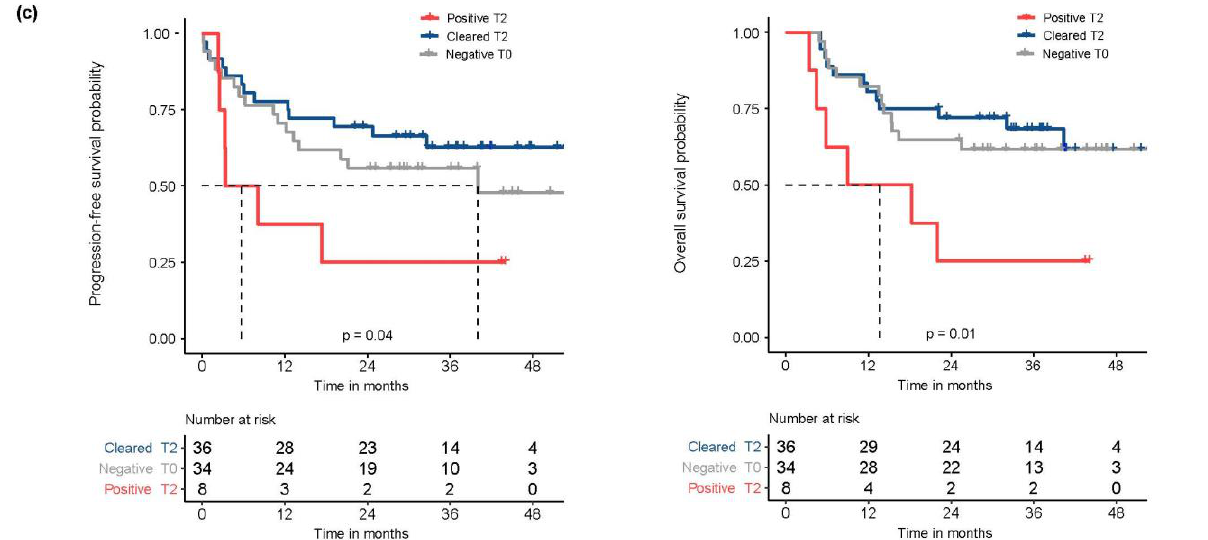
Figure 3. ctDNA dynamics and survival analysis: ( a ) ctDNA levels pre-CRT (T0) and preoperative (T2) combined with PET-CT response measurements and pathological response evaluation in grey. Patients are sorted according to ctDNA levels at T0 and presence of ctDNA at T2; ( b ) the time to progression (left panel) and progression-free follow-up (right panel); and ( c ) Kaplan – Meier analysis of progression-free survival and overall survival dividing patients according to ctDNA dynamics. Red ctDNA detected T0 and T2 (=positive T2); blue ctDNA detected T0, but not T2 (=cleared T2); grey ctDNA not detected T0 and T2 (=negative T0). Positron emission tomography – computed to- mography (PET-CT), circulating tumor DNA (ctDNA) .